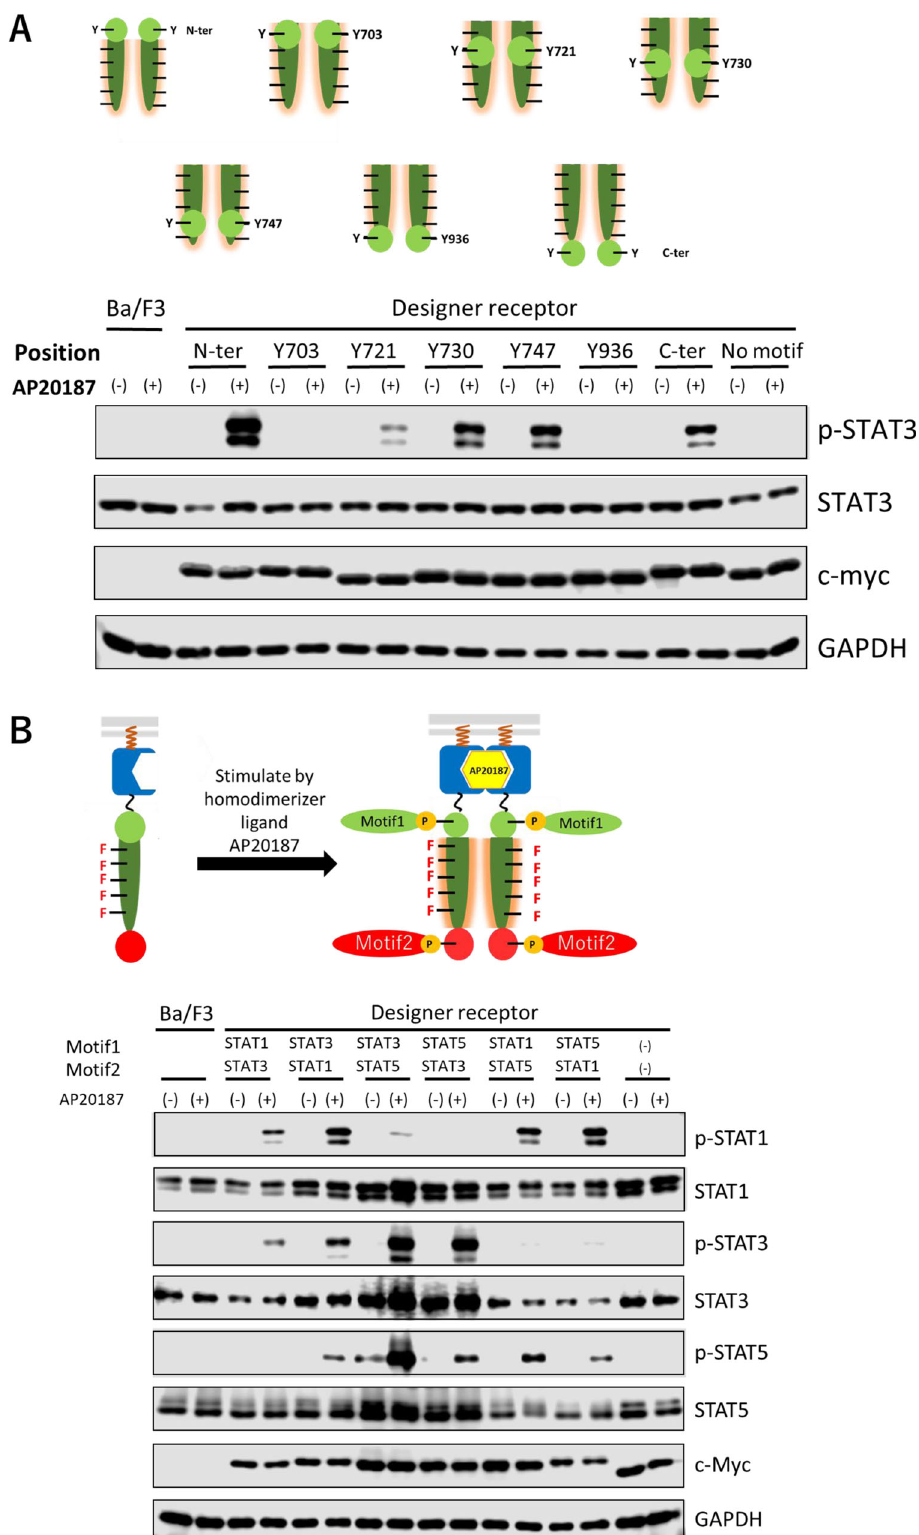
domain and the tyrosine motif, the kinase domain phosphory- lated the tyrosine motif, then recruited and activated the target signal transducer. Our results suggest that intracellular signal transduction pathways can be rationally designed by our designer receptor. In addition, signal transducers of interest were activated by placing corresponding tyrosine motifs on the